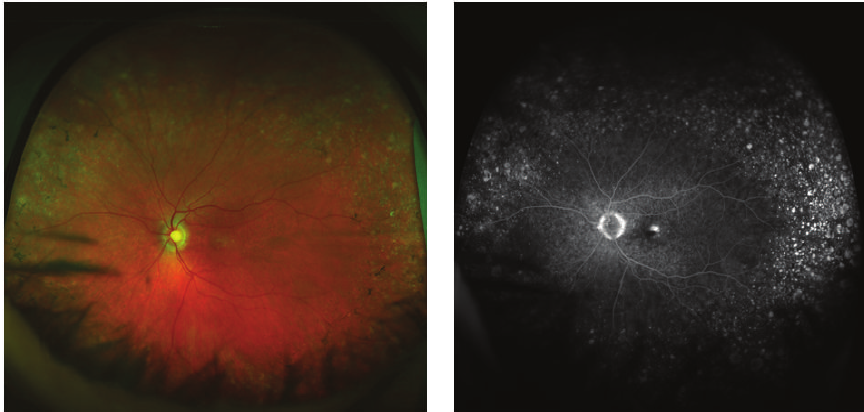
Figure 2: Optomap colour and fluorescein angiogram images showing extensive drusen, RPE mottling, and small areas of RPE atrophy in the retinal periphery in an eye with retinal angiomatous proliferation.